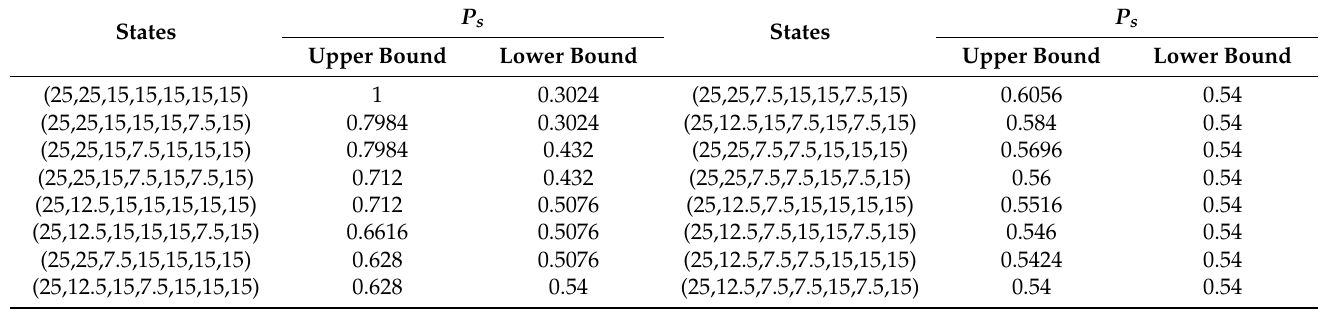
Table 10. Reliability upper and lower bounds analysis based on road network capacity.